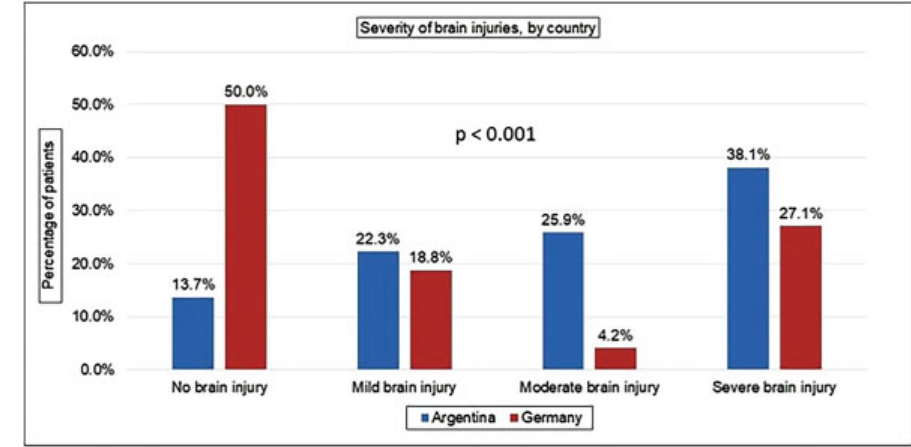
Fig. 1 Distribution of brain injuries by severity and